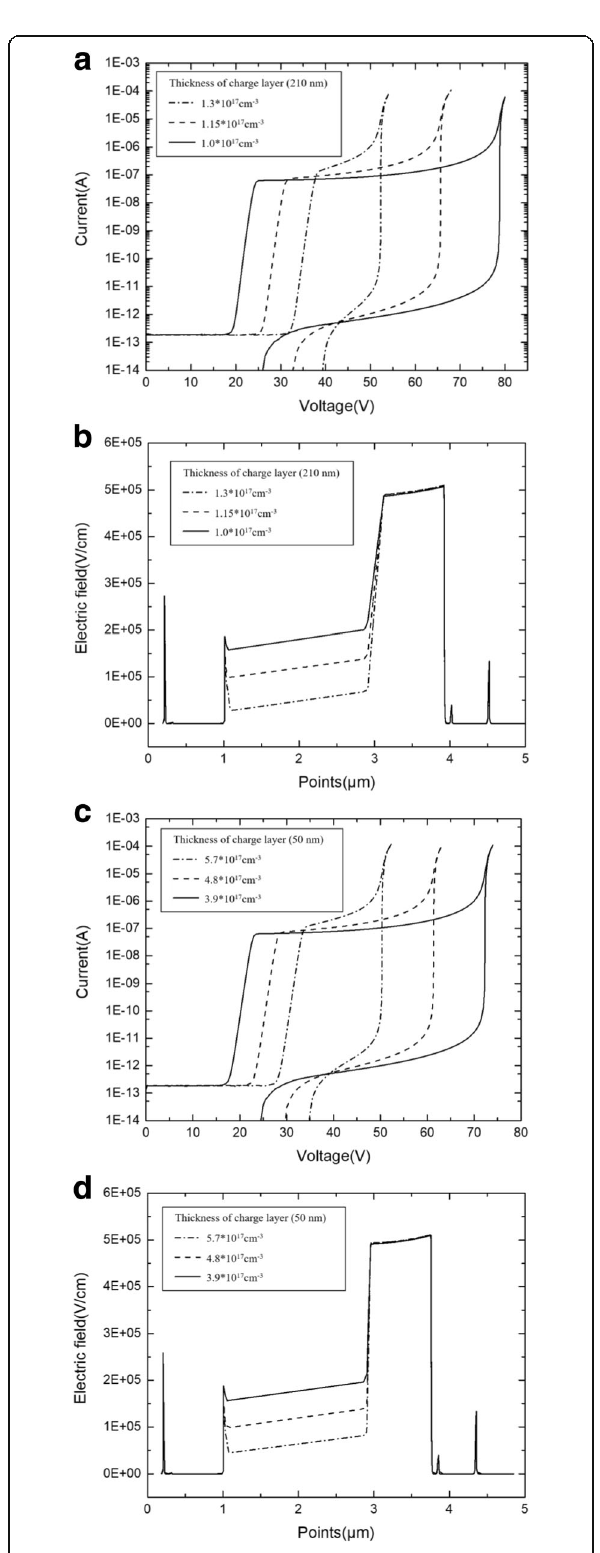
tunneling threshold value at or over the breakdown voltage, then the breakdown electric field in the multiplication will decrease. Groups B (APD-1 thickness of 90 nm, doping level of 2.4 × 10 17 cm − 3 in charge layer and APD-2 thickness of 90 nm, doping level of 3.6 × 10 17 cm − 3 ) were designed to demonstrate the relationship between the threshold electric field in the absorption layer and avalanche field in the multiplication layer. The multiplication and absorption electric fields vary with the bias voltage on the device. As shown in Fig. 12c, d, when the electric field in the absorption layer reaches the tunneling threshold value, the avalanche breakdown electric field in the multiplication gradually decreases. Moreover, when the absorption field exceeds the tunneling threshold, the avalanche breakdown electric field in the multiplication layer plummets. Furthermore, the absorption field slope increases when the electric field in the absorption layer exceeds the tunneling threshold.